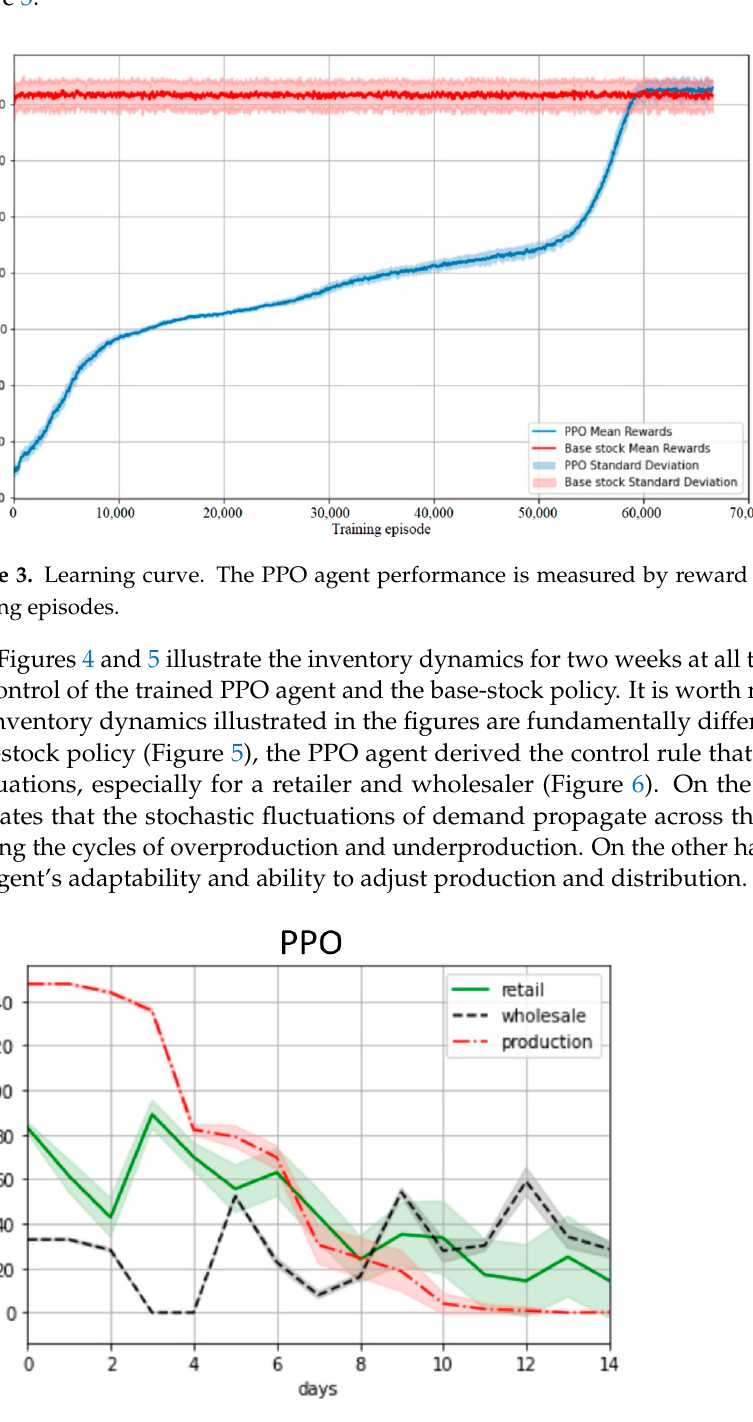
Figure 5. Inventory dynamics under the control of the base-stock policy during the first experiment.